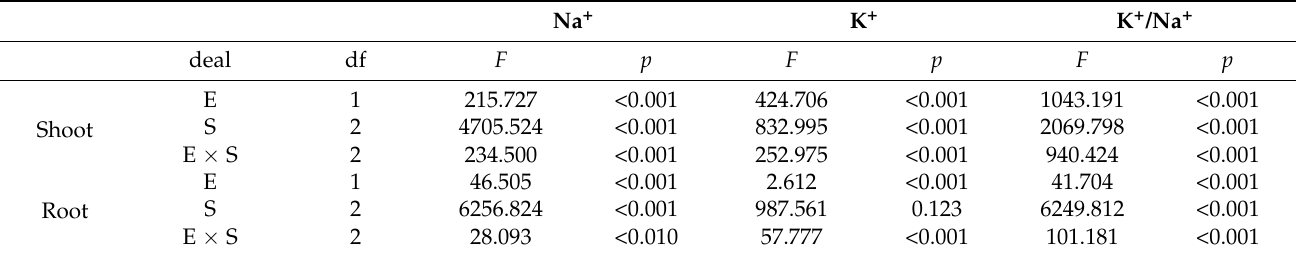
Figure 1. Effects of different alkali concentrations on K + ( A , B ), Na + ( C , D ) content and K + /Na + ( E , F ) in E+ and E − H. bogdanii shoots and roots. Note: Among different groups, when comparing the same E+ or E − plant, different lowercase letters of the column mark indicate a significant difference ( p < 0.05); in the same group E+ compared with E − , * indicates a significant difference ( p < 0.05). Table 2. Two − factor ANOVA of the effect of Epichloë endophytic fungi on Na + , K + content and K + /Na + of H. bogdanii shoots and roots under alkali stress.